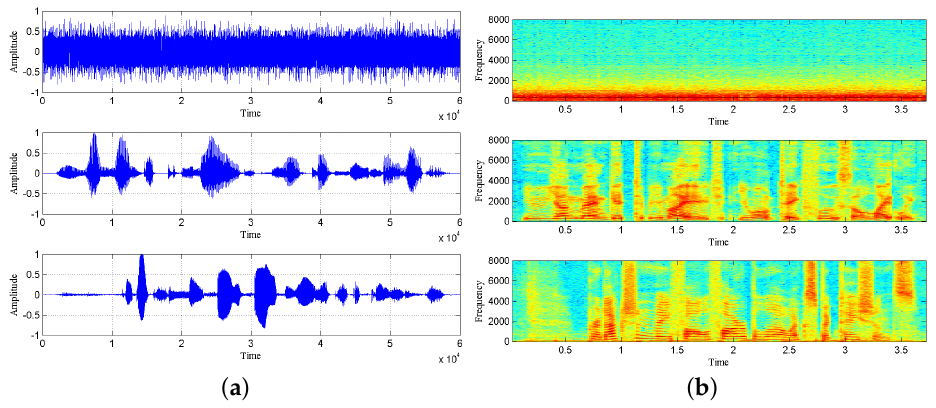
Figure 5. The separated signal graphic information is obtained by using the Fast IVA algorithm. ( a ) Time–domain waveform of separated signals; ( b ) Spectrogram of separated signals.